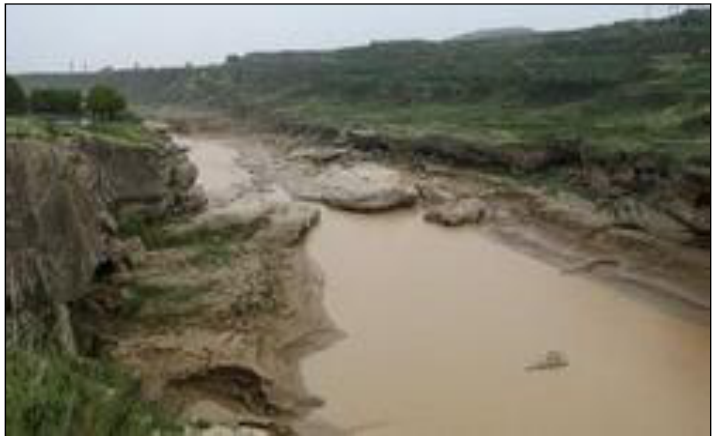
Figure 4. Zheng Guo Qi